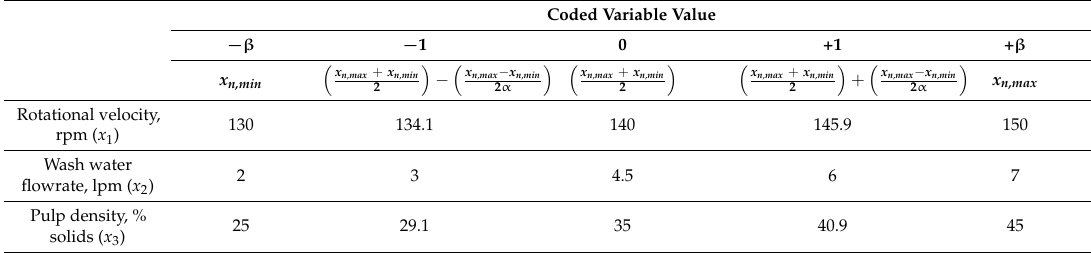
Table 1. Summary of values used for variable levels in CCRD experimental design programme.